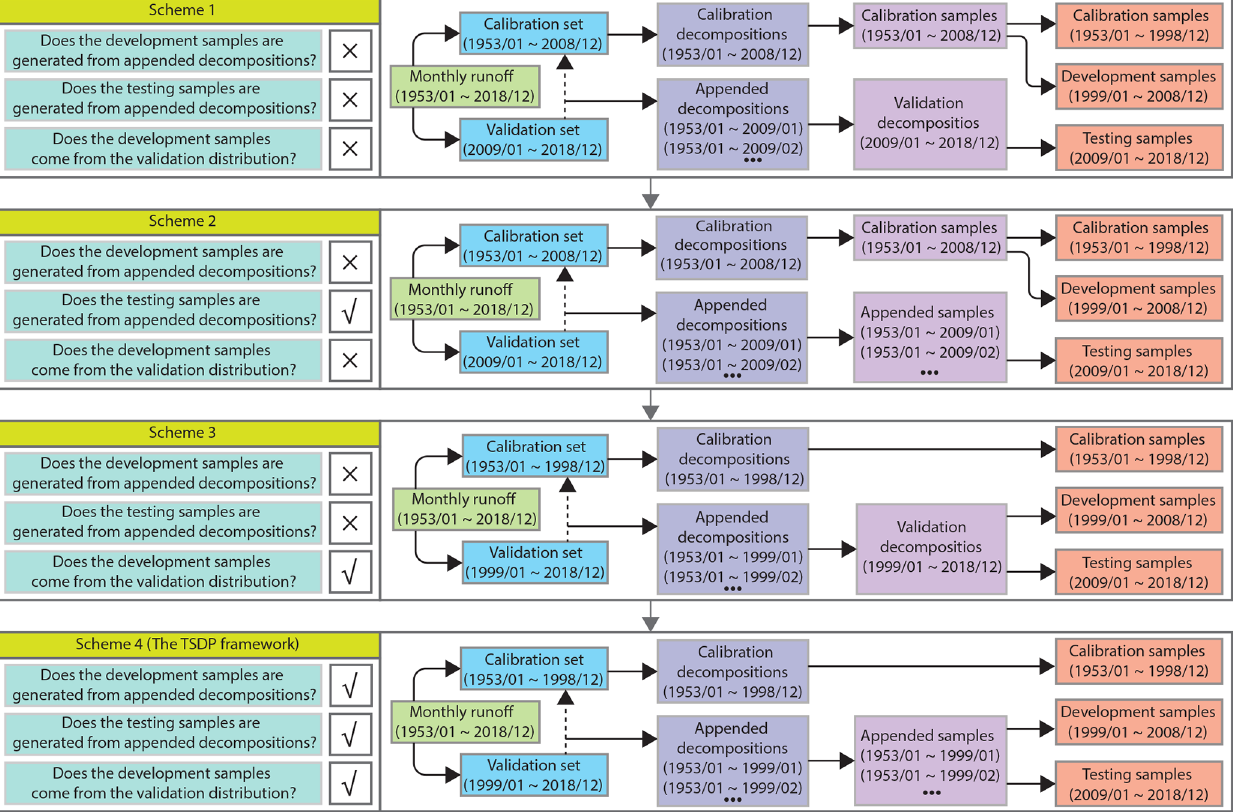
Figure 8. A block diagram for different methods of generating the calibration, development and test samples.